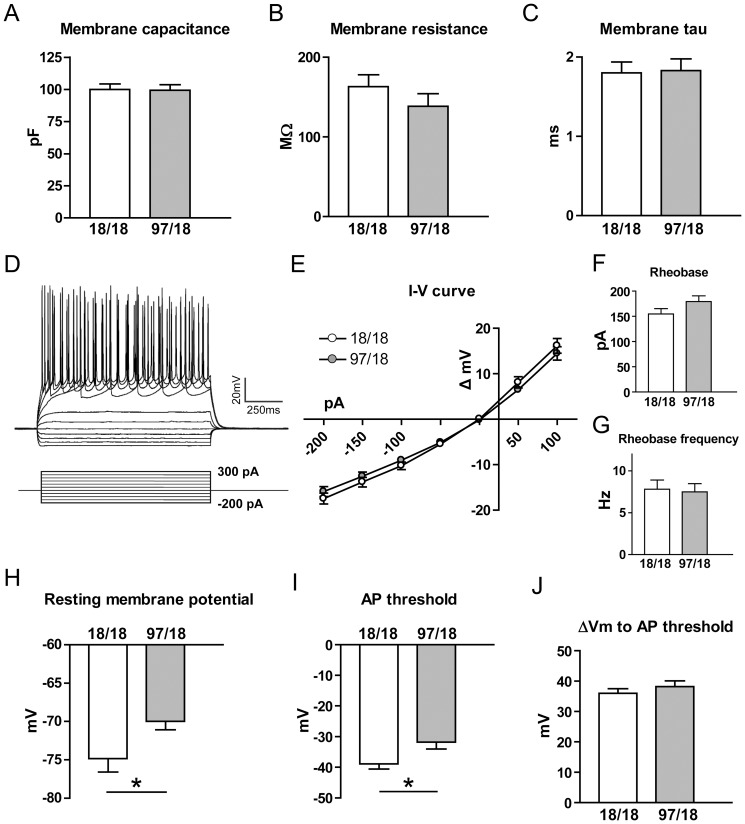
Alterations in basic membrane properties of Hu97/18SPNs. (A–C): Membrane capacitance (A), membrane resistance (B), and membrane time constant (C) did not differ between Hu18/18 and Hu97/18 SPNs. Membrane capacitance measurement was pooled from the experiments with potassium-based and caesium-based internal solutions (Hu18/18 n = 46, Hu97/18 n = 44), while membrane resistance and tau were measured with potassium-based internal solution only (Hu18/18 n = 21, Hu97/18 n = 17). (D – J): Cells were patch-clamped with potassium-based solution, and membrane voltage changes in response to the injected current were recorded and analysed. (D) Representative I–V response of a Hu18/18 SPN to current injection (50pA increments from -200pA, 1 s each). (E) I–V curves showed no difference between Hu97/18 and Hu18/18 SPNs. (F) Rheobase and (G) rheobase frequency were not different between the genotypes. (H) Hu97/18 had a lower resting membrane potential than Hu18/18 SPNs (p = 0.03). (I) Action potential (AP) threshold was more depolarized in Hu97/18 SPNs (p = 0.02). (J) The change in membrane voltage from resting potential to AP threshold was not different between Hu18/18 and Hu97/18 SPNs. For the experiments in D–J, Hu18/18 n = 11 and Hu97/18 n = 12. *p<0.05 (unpaired Student’s t-test).